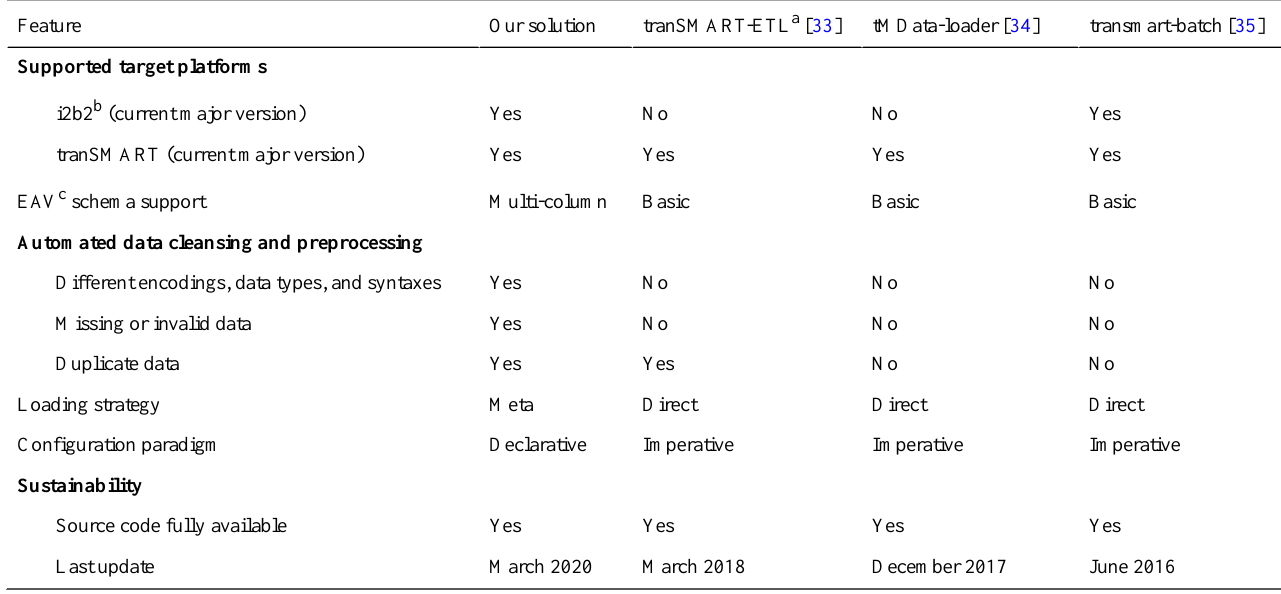
Table 6. Comparison of extraction-transformation-loading tools: Our solution, tranSMART-ETL a , tMData-loader, and transmart-batch.